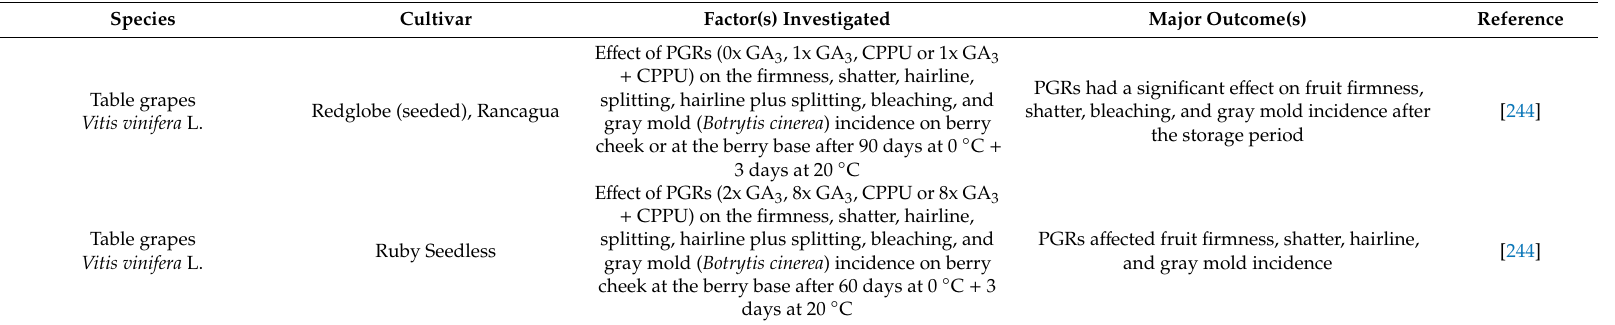
ABS = alternaria black spot; CPPU = N -(2-chloro-4-pyridyl)- N’ -phenylurea; DAFB = days after full bloom; GA = gibberellins / gibberellic acid; NAA = naphthaleneacetic acid; PGRs = plant growth regulators; SO 2 = sulfur dioxide; TDZ =